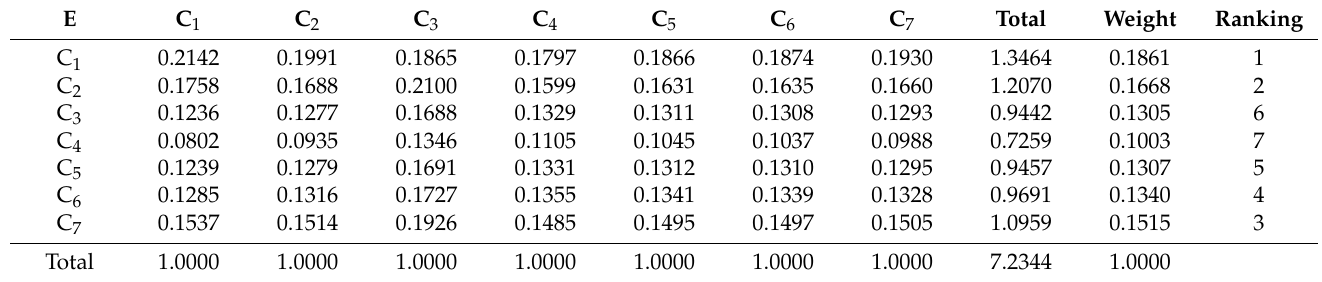
Table 10. Normalized matrix of priority weight and rank of influential criteria in